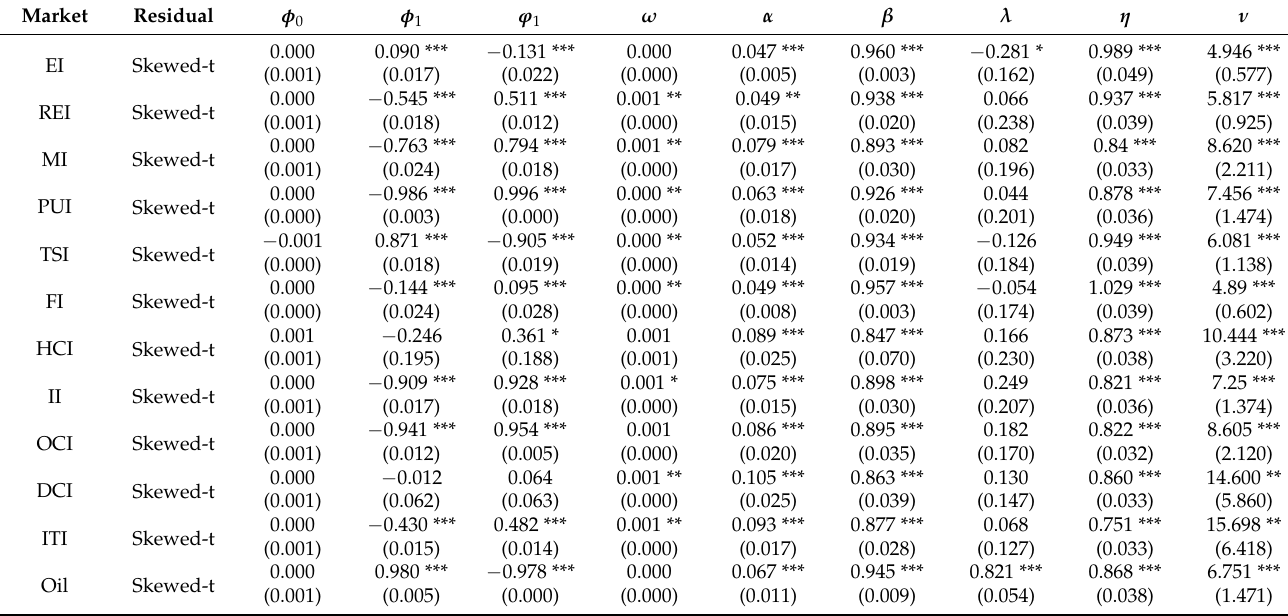
Table 2. Estimates of marginal distribution models (before the reform).